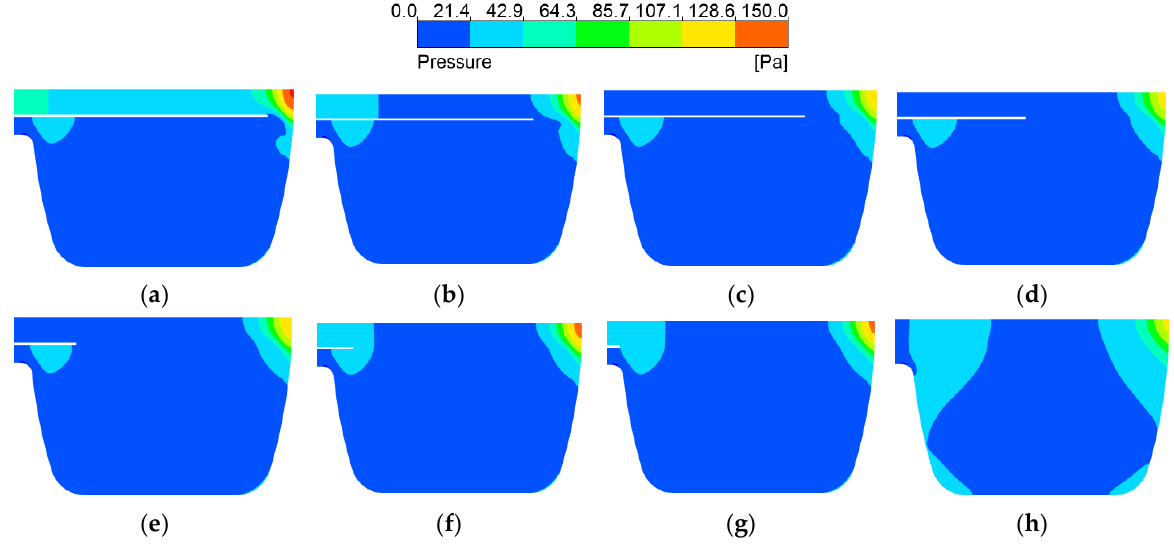
Figure 10. Pressure distribution in CHM: ( a ) H/D = 0.5; ( b ) H/D = 1; ( c ) H/D = 1.5; ( d ) H/D = 3; ( e ) H/D = 4.5; ( f ) H/D = 5; ( g ) H/D = 5.5; ( h ) H/D = 6.